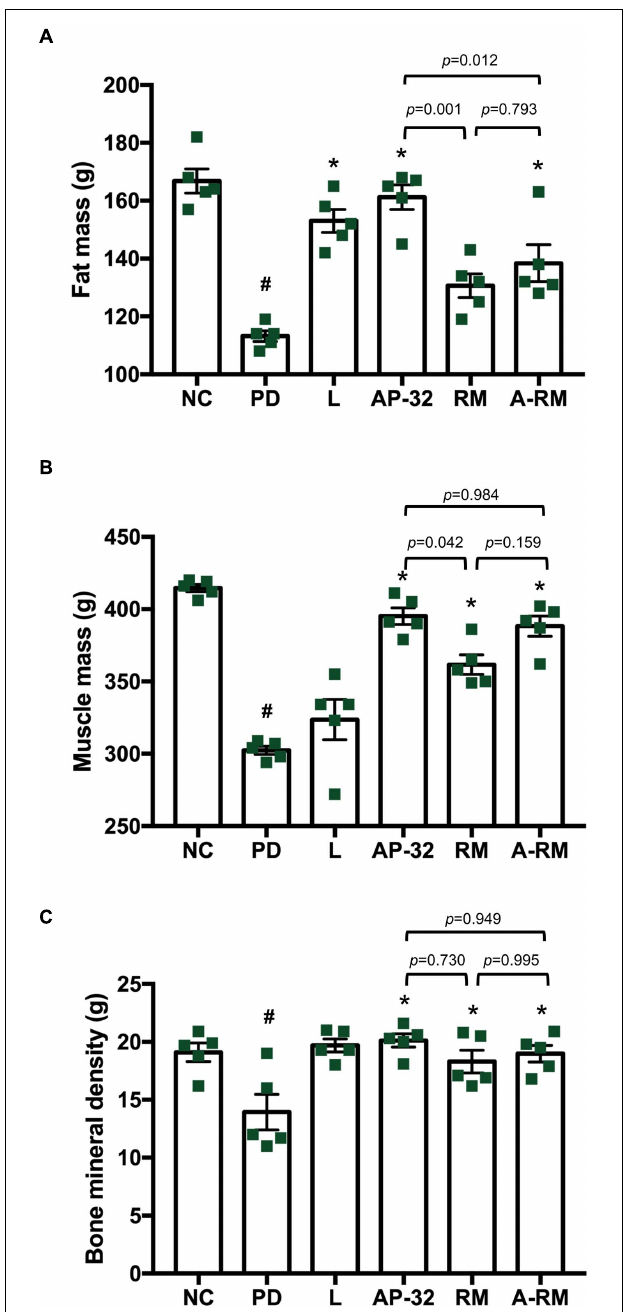
FIGURE 5 | Body composition of rats after 8 weeks of treatments. Body composition was evaluated by Dual-Energy X-Ray Absorptiometry (DXA), which includes (A) fat mass, (B) muscle mass, and (C) bone mineral density. All data are expressed as mean ± SEM ( n = 5 rats/group). * p < 0.05 compared to PD group. Data were evaluated by one-way ANOVA with Tukey’s post hoc test. # p < 0.05 PD group compared to NC group.